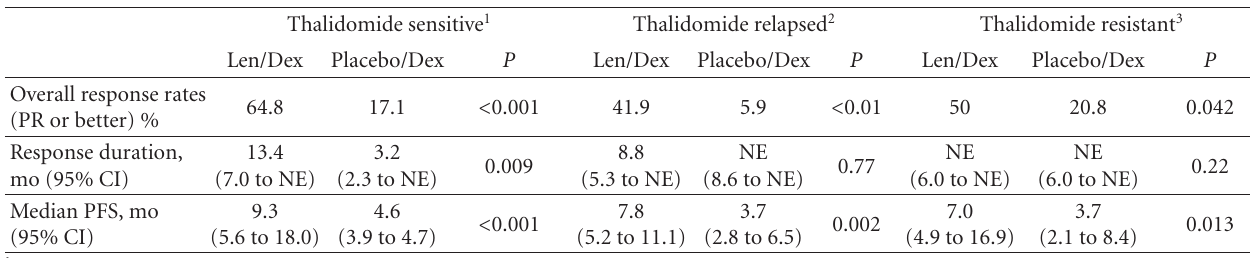
Table 6: The e ff ect of Len/Dex treatment according to prior response to thalidomide. Adapted from Wang et al.